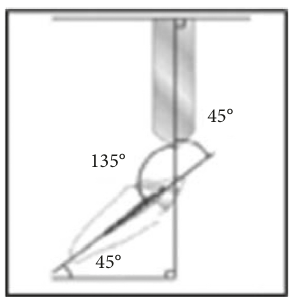
Figure 10: Schematic representation of load at an angle of 135 ° to the root long axis (45 ° to the horizontal plane).